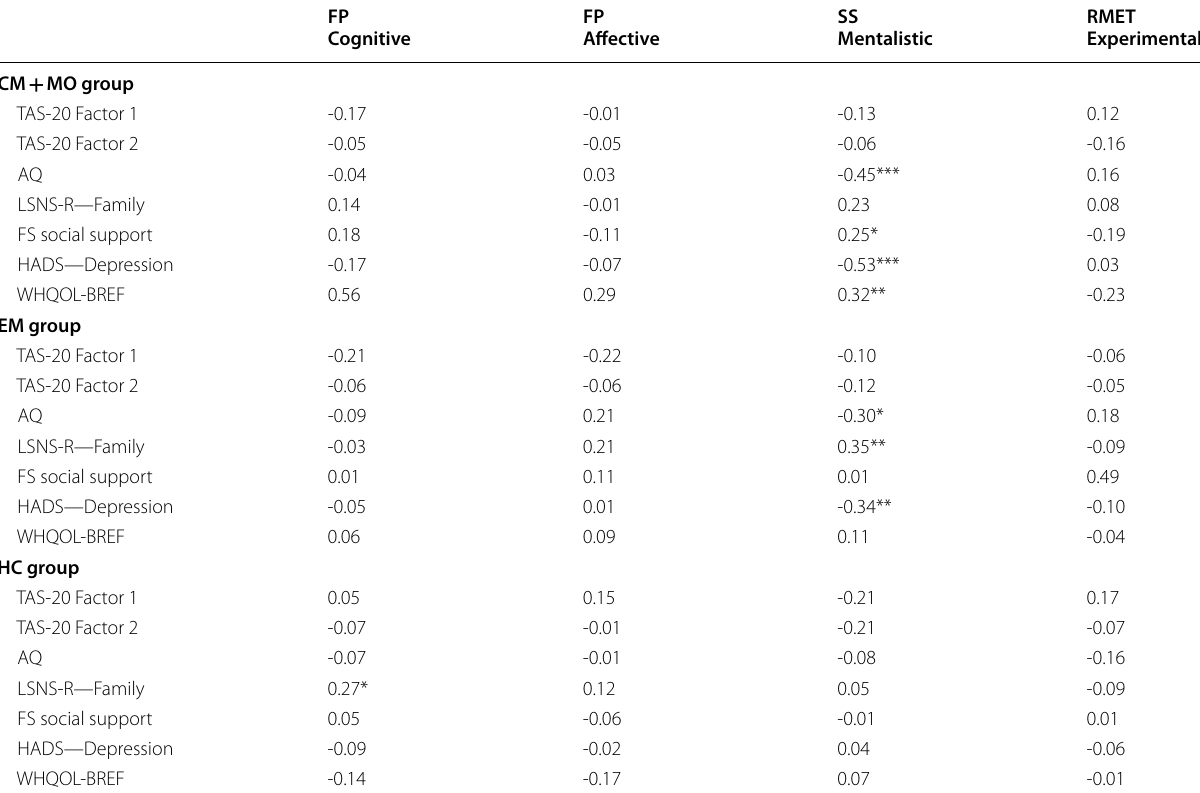
Table 4 Correlation between socio-cognitive abilities and other variables in which we found group differences, separately for each